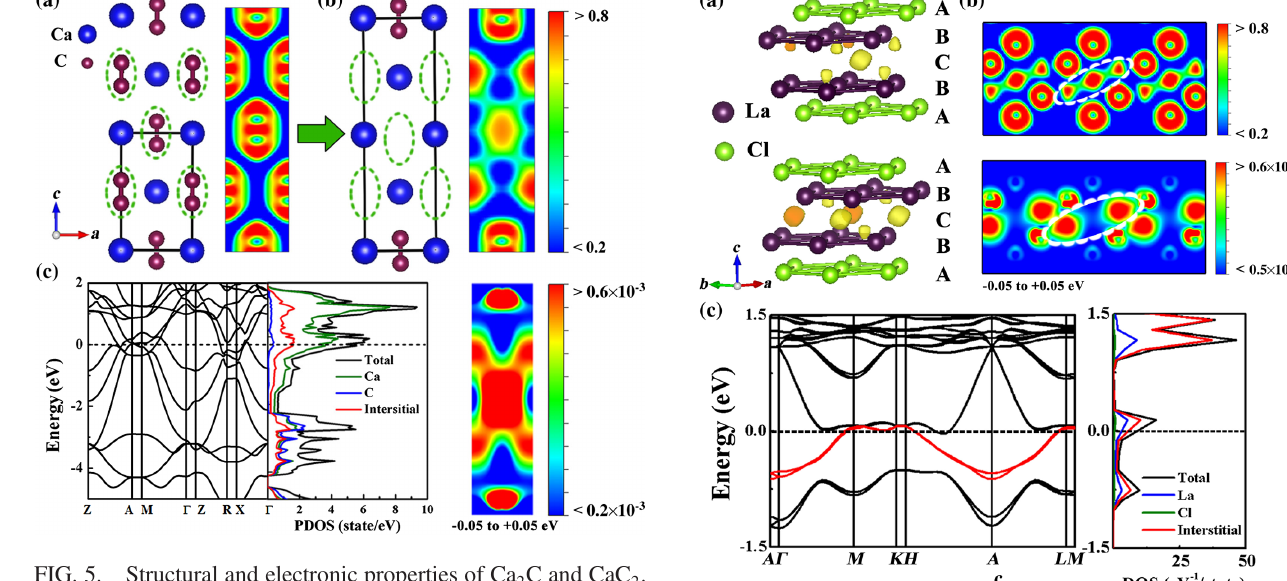
zone.FIG. 5. Structural and electronic properties of Ca 2 C and CaC 2 . (a) Crystal structure (left-hand panel) and ELF (right-hand panel) 0¯12 Þ on the ð R plane of CaC 2 . (b) Crystal structure (left-hand panel) and ELF (right-hand panel) on the ð 012 Þ R plane of Ca 2 C. Excess electrons localize in the interstitial regions indicated by dashed circles. (c) Electronic properties of Ca 2 C: band structure and projected density of states (PDOS) (left-hand panel), and partial electron density for region near E F ( j E j < 0 . 05 eV) on the ð 012 Þ R plane (right-hand panel). The dashed line indicates the Fermi energy ( E F